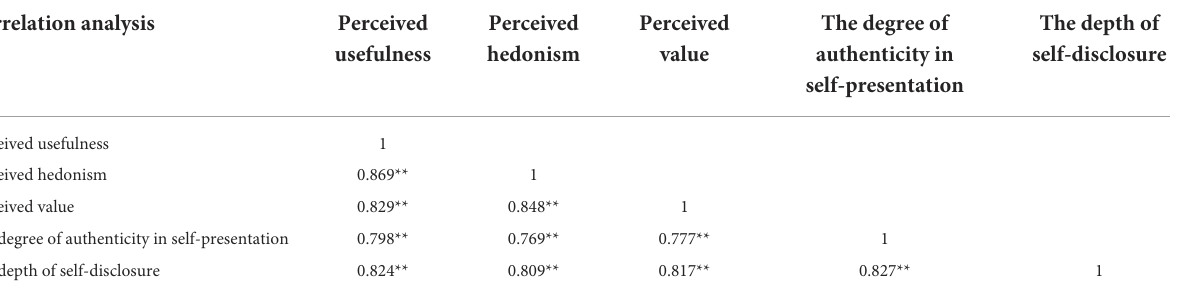
TABLE 6 Spearman rank correlation analysis on the